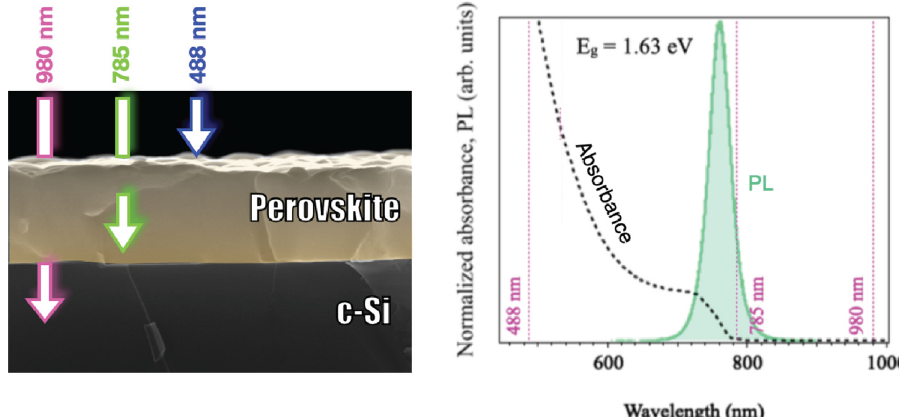
Fig. 1. The idea of the experiments performed in this work: the use of the laser of different wavelengths allows to induce SPV effect in different regions of the sample. Based on PL/absorbance results showed on the graph, the 980 nm illumination is not absorbed by PVK layer but only by c-Si below and on the other hand the 488 nm laser is absorbed mostly at the